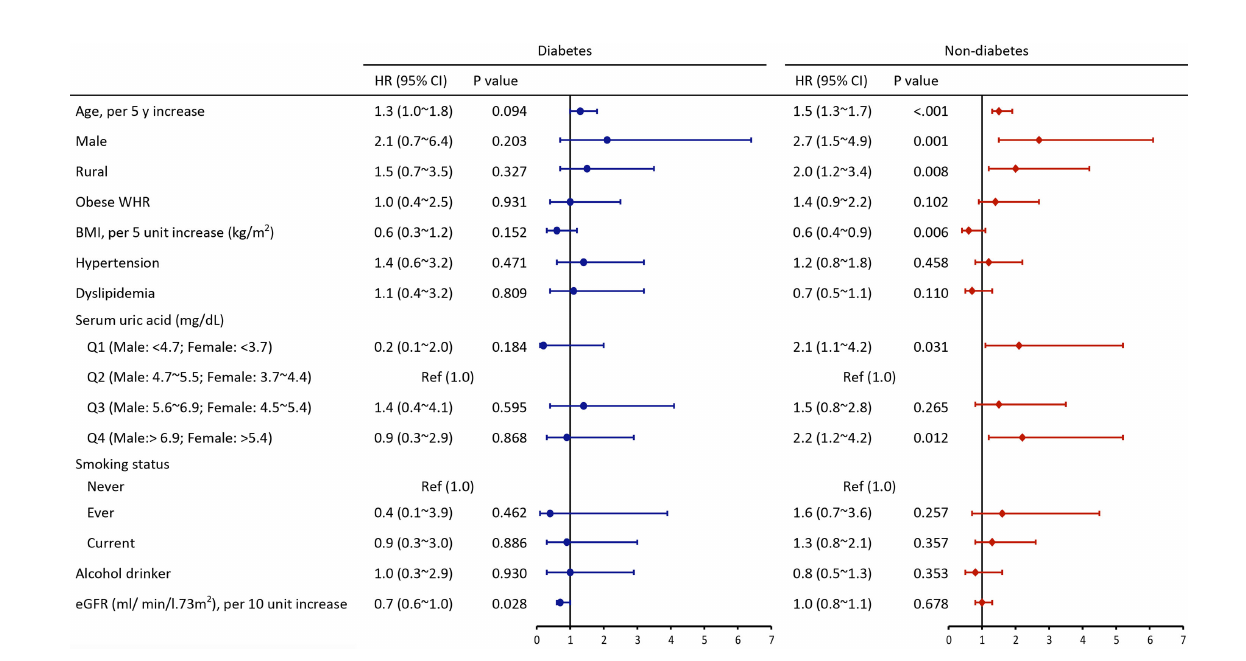
FIGURE 2 | Multivariate adjusted hazard ratios of risk factors for all-cause mortality among individuals with and without diabetes (HR, hazard ratios; CI, con fi dence interval; Other abbreviations are indicated in Table 1